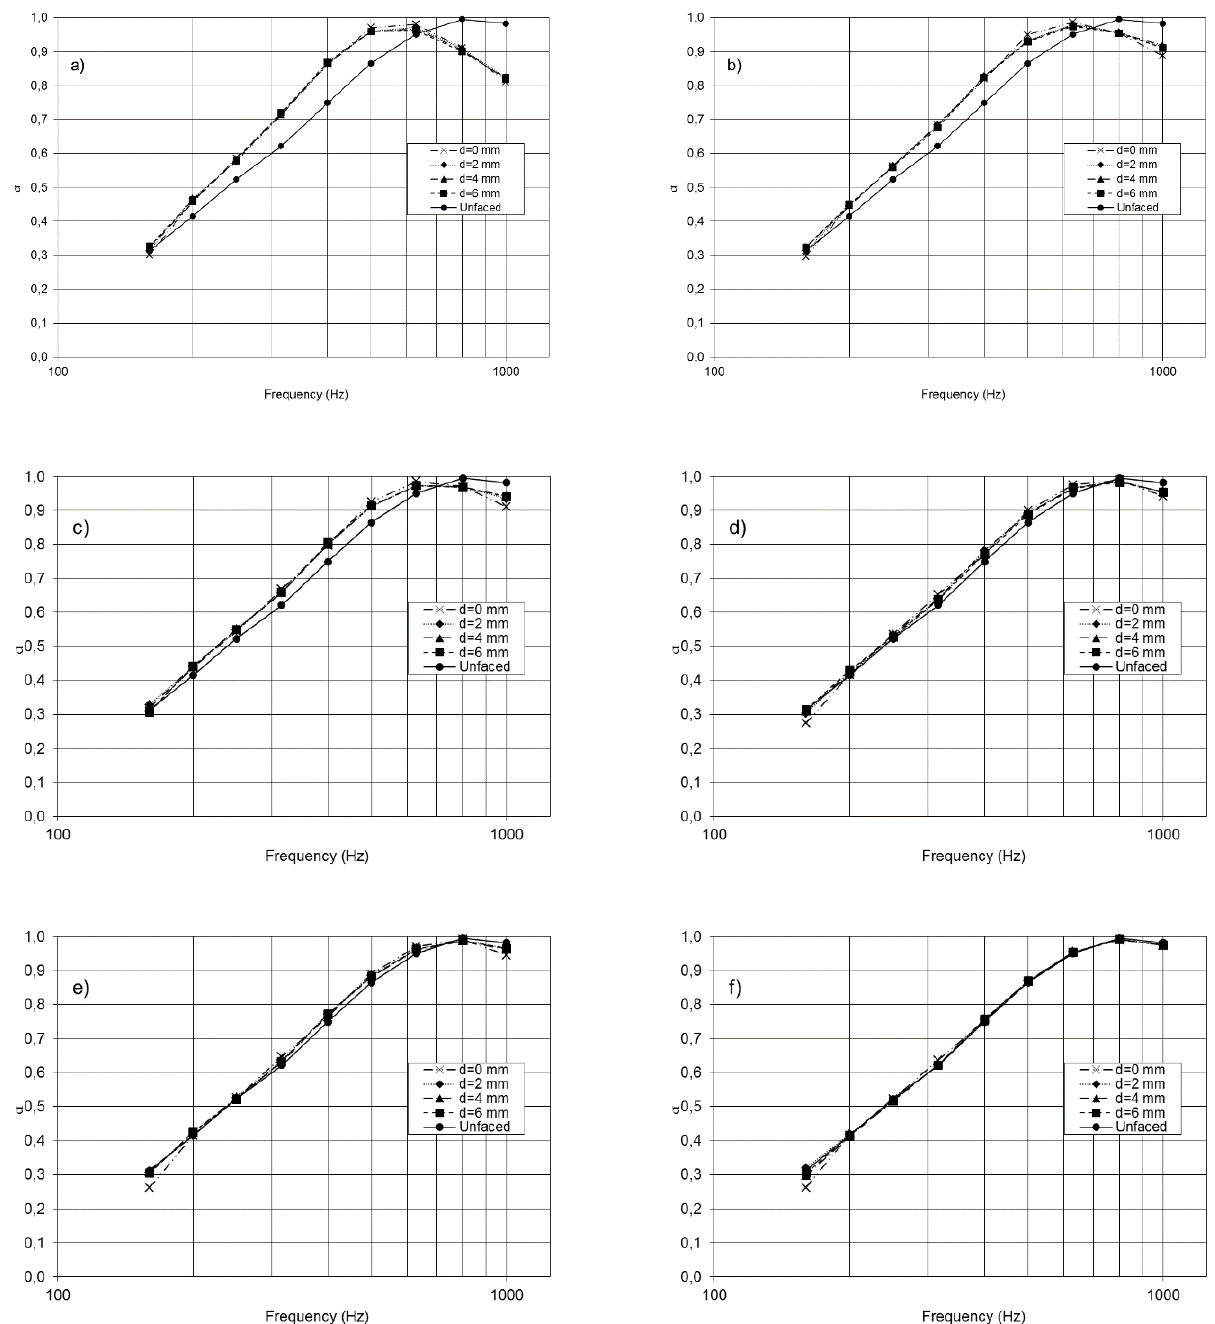
Figure 9: Absorption coeflcient curves for different air gaps, d, between the perforation and the absorbing material: a) σ = 4.9%; b) σ = 7.7%; c) σ = 10 %; d) σ = 15%; e) σ = 20%; f) σ =